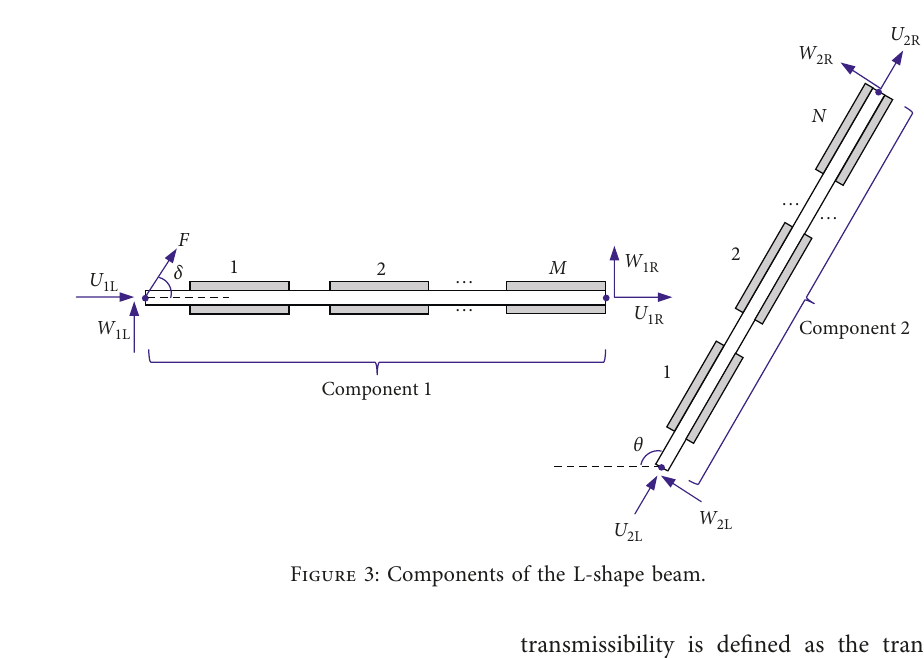
Figure 3: Components of the L-shape